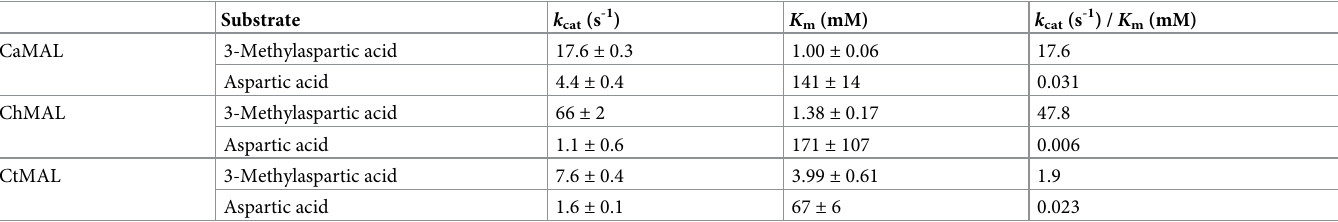
Table 1. Steady-state kinetic constants for the activity of MAL enzymes on 3-methylaspartic acid and aspartic acid. Substrate k cat (s -1 ) K m (mM) k cat (s -1 ) / K m (mM) CaMAL 3-Methylaspartic acid 17.6 ± 0.3 1.00 ± 0.06 17.6 Aspartic acid 4.4 ± 0.4 141 ± 14 0.031 ChMAL 3-Methylaspartic acid 66 ± 2 1.38 ± 0.17 47.8 Aspartic acid 1.1 ± 0.6 171 ± 107 0.006 CtMAL 3-Methylaspartic acid 7.6 ± 0.4 3.99 ± 0.61 1.9 Aspartic acid 1.6 ± 0.1 67 ± 6 0.023 Values and standard errors for apparent affinity constant (Michaelis constant, K m ) and maximal enzyme turnover (catalytic constant, k cat ), and values for enzyme efficiency values ( k cat / K m ). Reactions at 30˚C in 0.25 M Tris pH 9, 20 mM MgCl 2 and 1 mM KCl. Means and 95% confidence